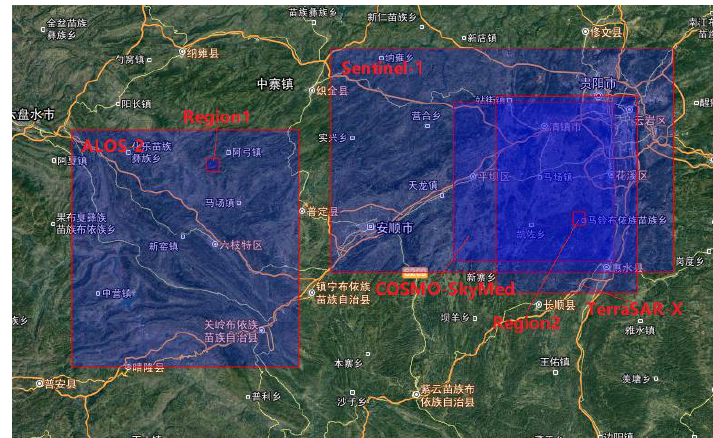
Figure 4 The coverage area of SAR